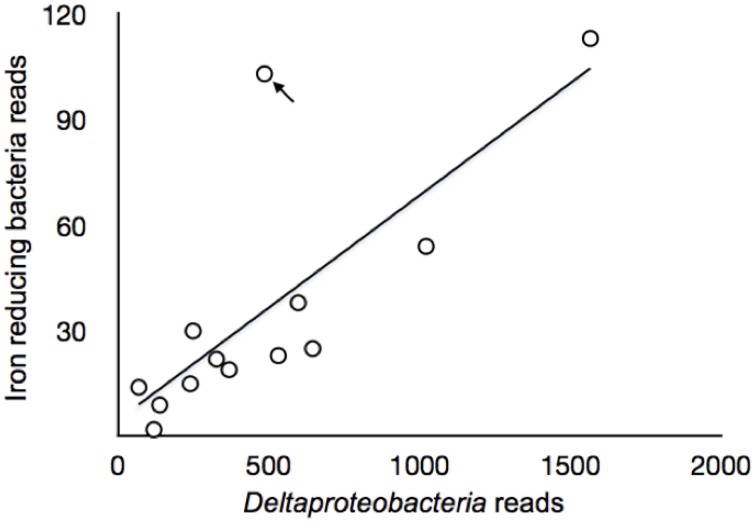
Correlations between sequence reads of samples collected of sulfate-reducing deltaproteobacteria and iron reducing bacteria in Zone 3. The arrow points to the A3 4–6 cm, where the sample differed from all other samples and was discussed in the text.